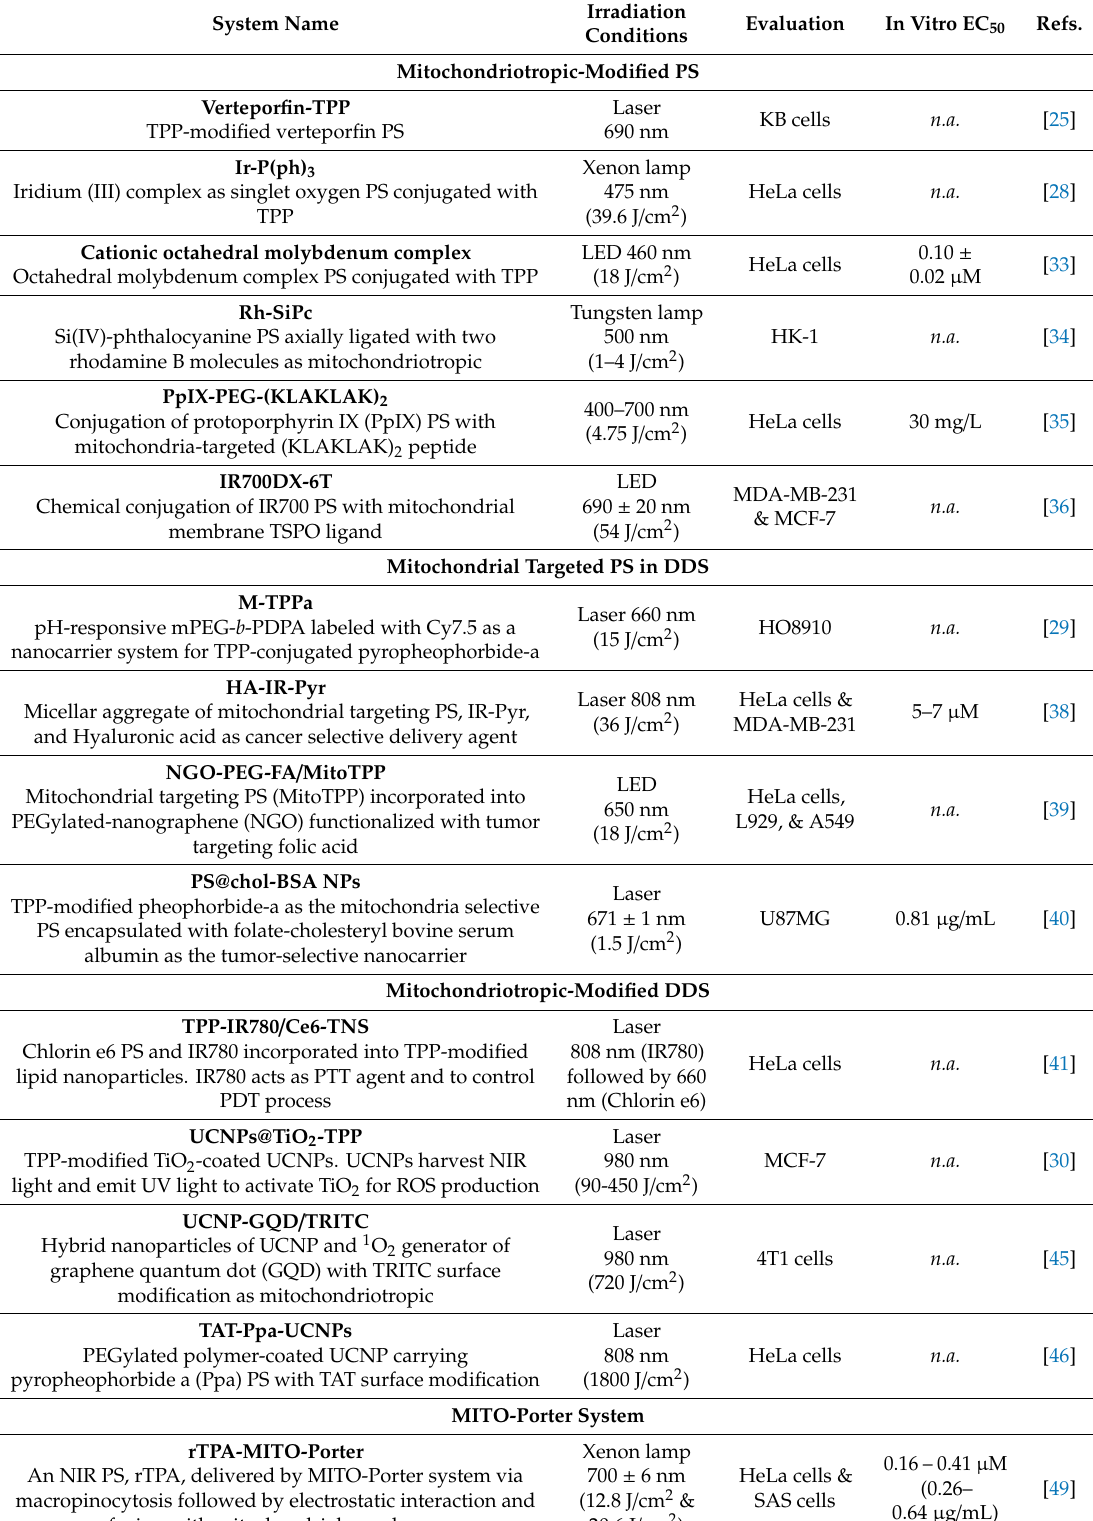
Table 1. Summary of mitochondrial targeting PDT and the PTT strategy for cancer